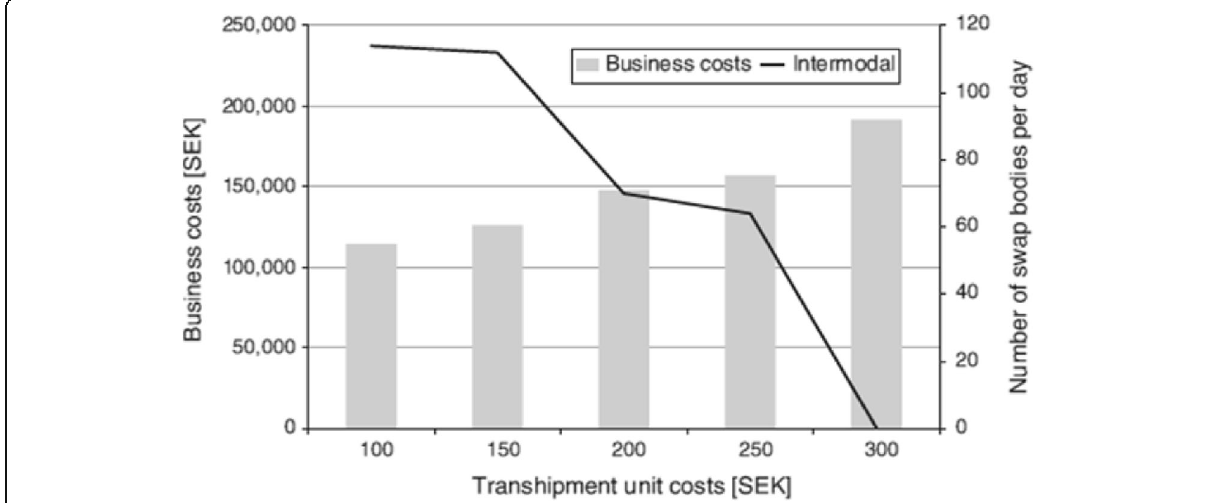
Fig. 2 Total cost trend in SEK, as a function of terminal operations costs [13]